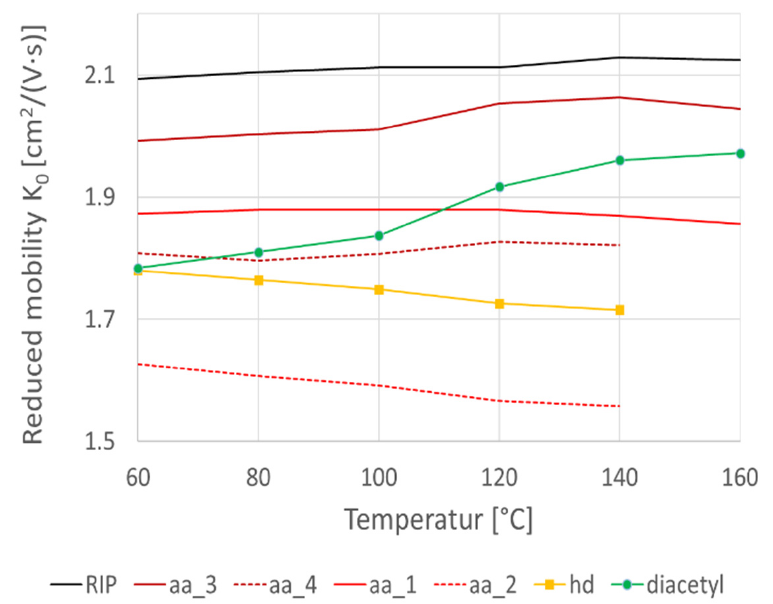
Figure 2. Reduced ion mobility (K 0 ) of acetic acid (aa_1, aa_2, aa_3, and aa_4, red), diacetyl (green), and their heterodimer (hd, yellow) depending on the drift tube temperature ( x -axis). and their heterodimer (hd, yellow) depending on the drift tube temperature ( x